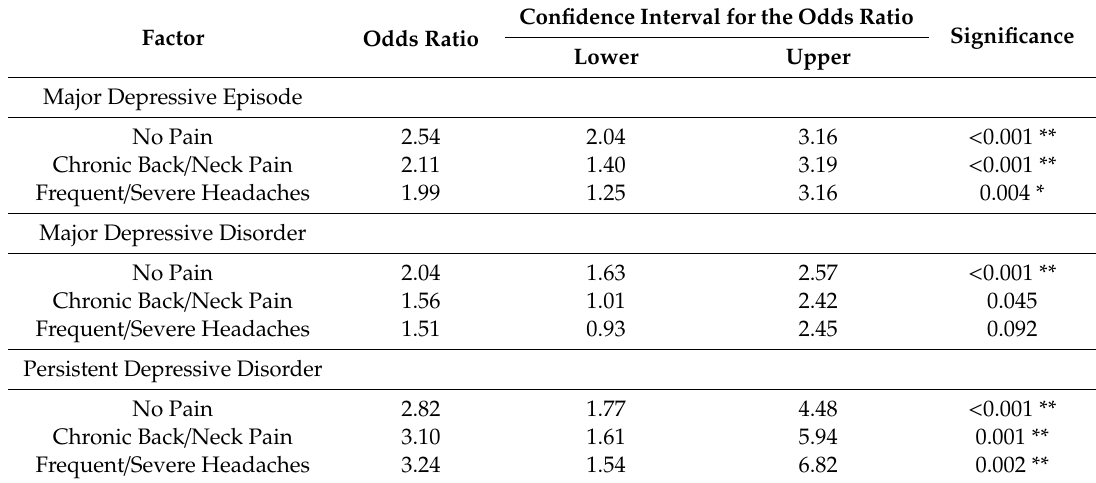
Table 2. Odds Ratios for the Association Between Depression and Alcohol Abuse in the Presence or Absence of Chronic